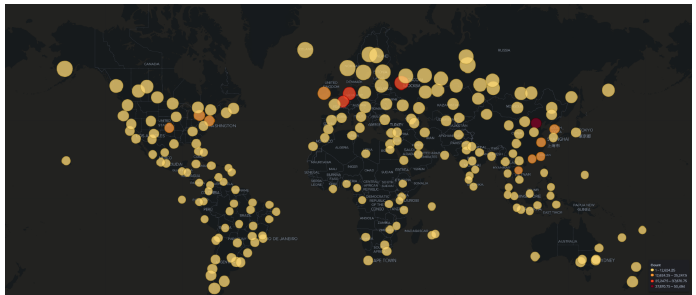
Figure 6. GCP Honeypot Attack Map.